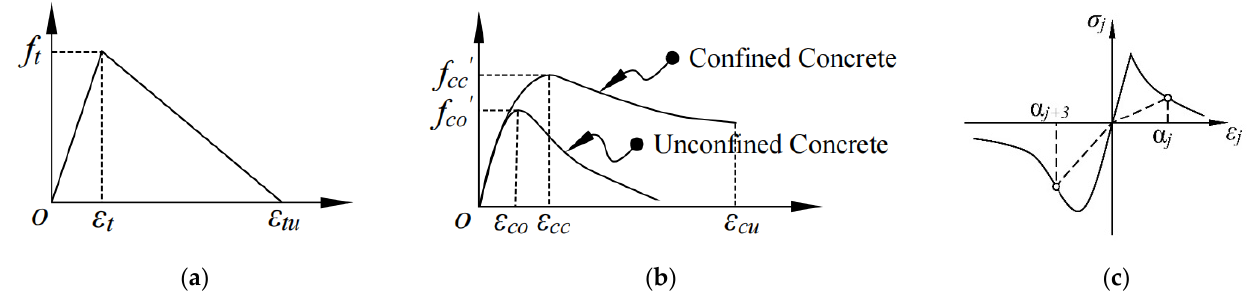
Figure 4. The constitutive relationship of concrete: ( a ) tension; ( b ) compression; ( c ) loading–unloading protocol.